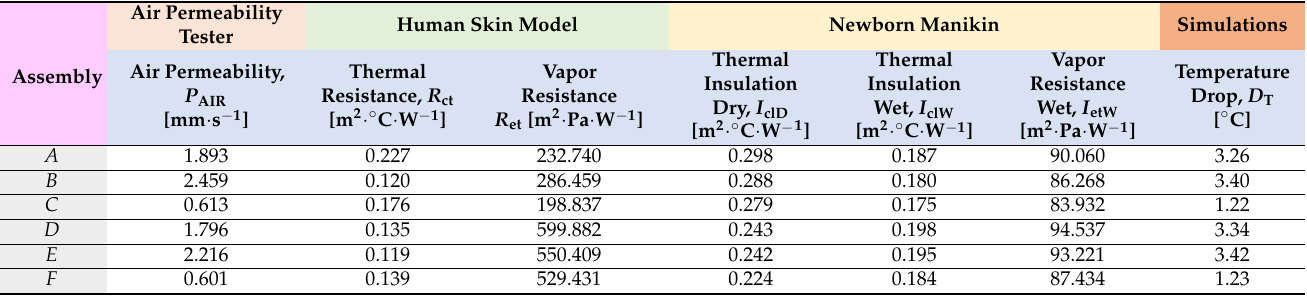
Table 4. Measured and simulated biophysical properties of tested assemblies [23,29].